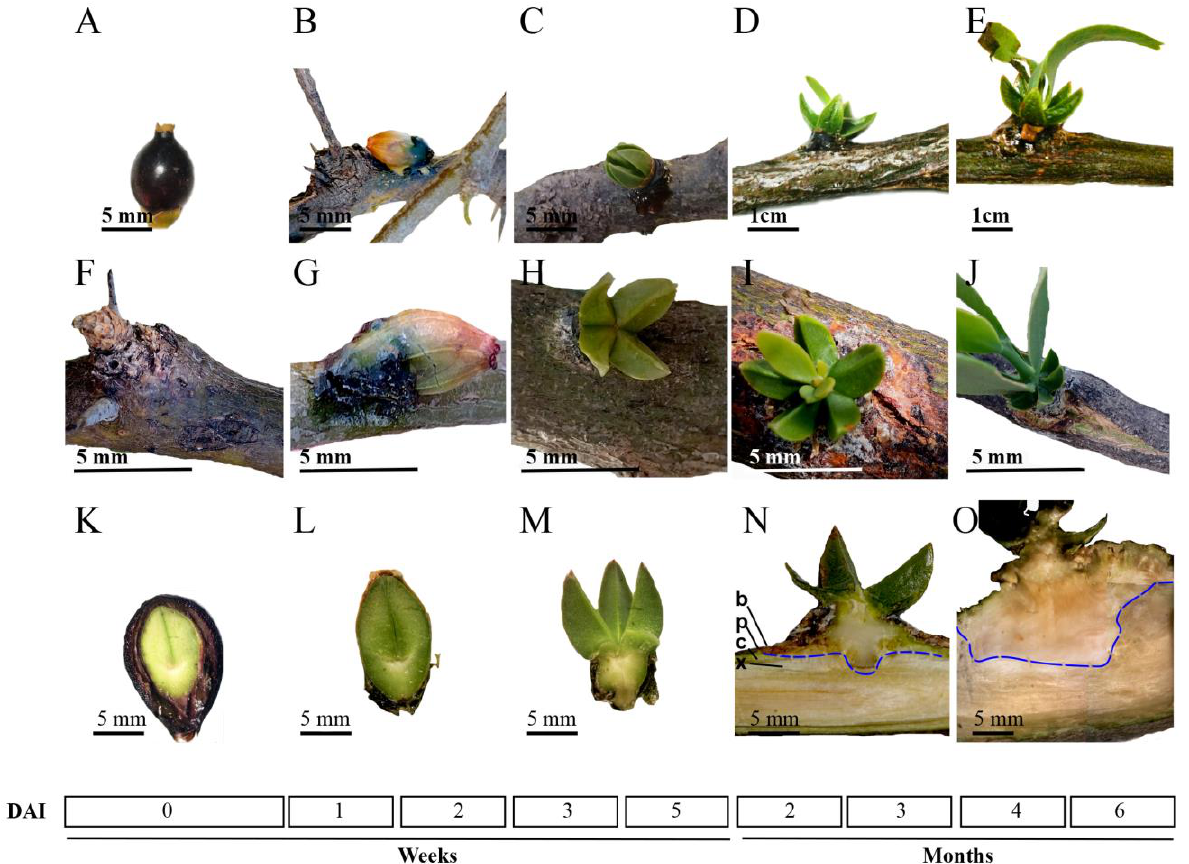
Figure 1. Infective stages of P. calyculatus on the mesquite host tree branch. Representative images were analyzed according to phenological shoot characteristics: ( A ) T1 stage corresponds to mature seed/fruit; ( B ) T2 stage, germination/holdfast formation; ( C ) T3 stage, seedling establishment/haustorium activation; ( D ) T4 stage, haustorium penetration; and ( E ) T5 stage, haustorium connection with the xylem. Bark of host without mistletoe seed ( F ); seed viscin on the bark ( G ); dry viscin fusion with bark ( H ); bark breakdown ( I ); and haustorium bulge formation ( J ). Transversal dissection of each invasive stage: T1 ( K ), T2 ( L ), T3 ( M ), T4 ( N ), and T5 ( O ). The scale bar in each picture is indicated. DAI: days after inoculation. b: bark, p: phloem, c: cambium, and x: xylem. Dashed blue line indicates the limit between haustorium and host tissues.